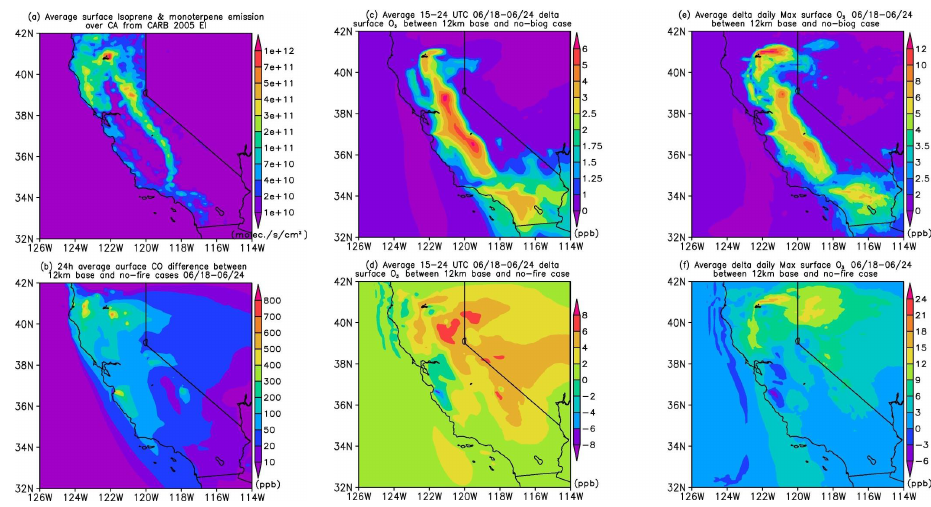
Figure 4 (a) Average surface isoprene and monoterpene emissions from CARB EI (b) 24h-average differences of CO between base and no-fire cases in 12 km grids; Surface O 3 differences between (c;e) base and no-biogenic cases and (d;f) base and no-fire cases of (c-d) averaged 15-24 UTC (8-17 local time) and (e-f) average daily maximum O 3 in 12 km grids.